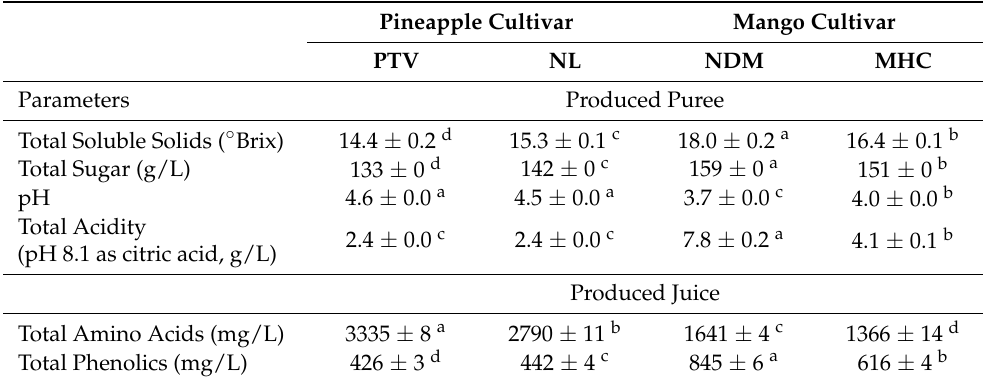
Table 1. Properties of the produced purees and juices of the pineapple (PTV and NL) and mango cultivars (NDM and MHC). Each value shows the mean ± standard deviation from three measure- ment replicates. Different letters (a–d) derived from the ANOVA and DMRT test indicate significant differences among